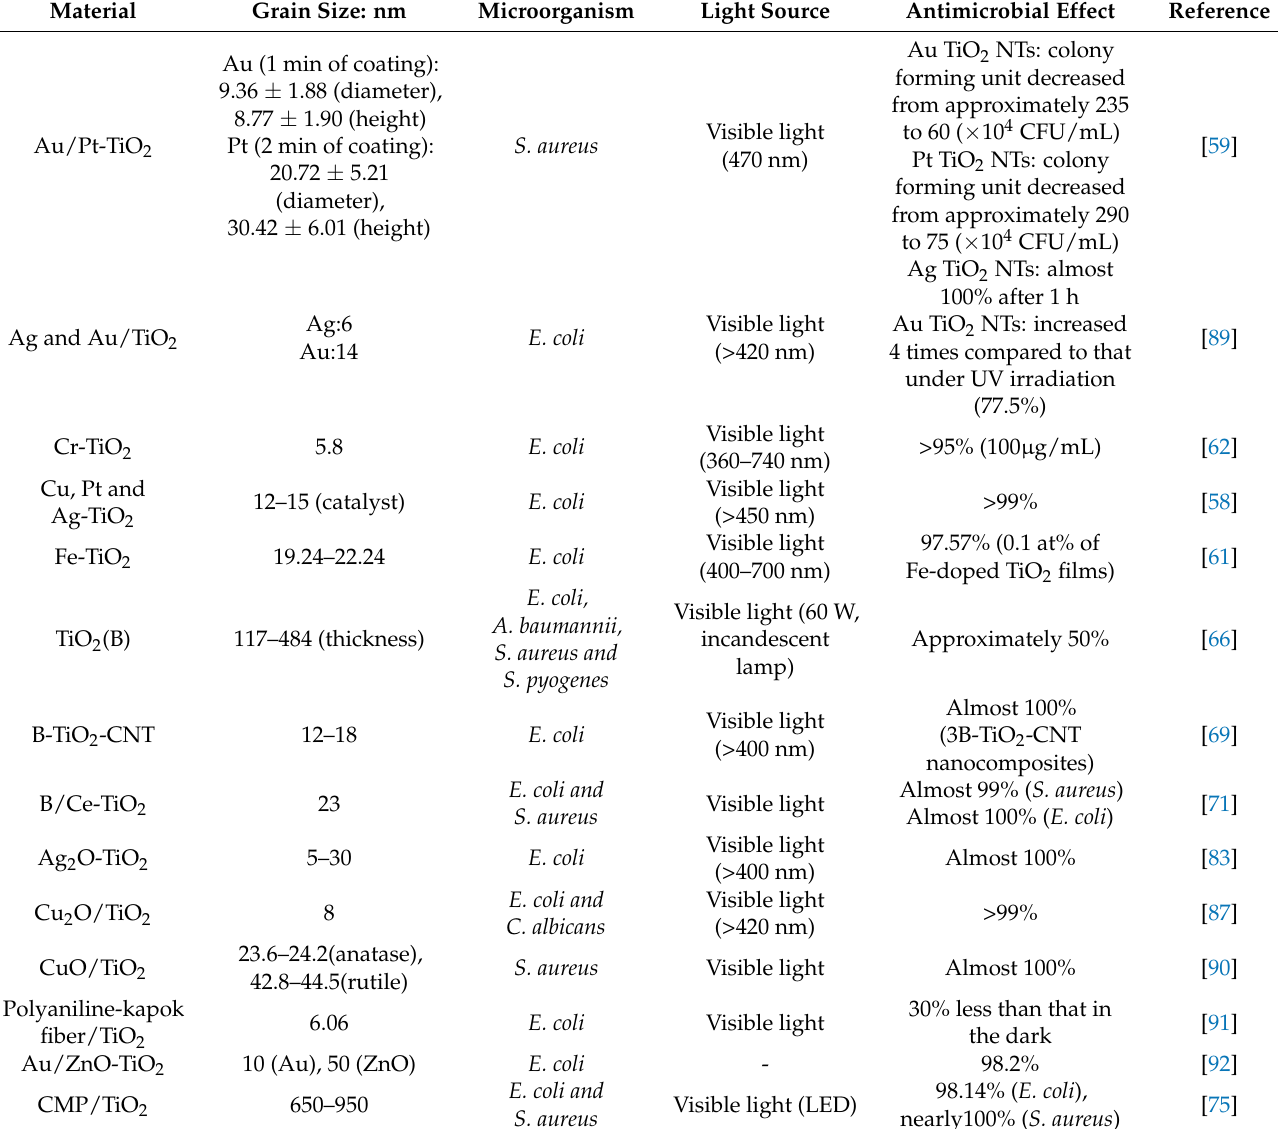
Table 2. Antimicrobial effect of different TiO 2 materials under visible